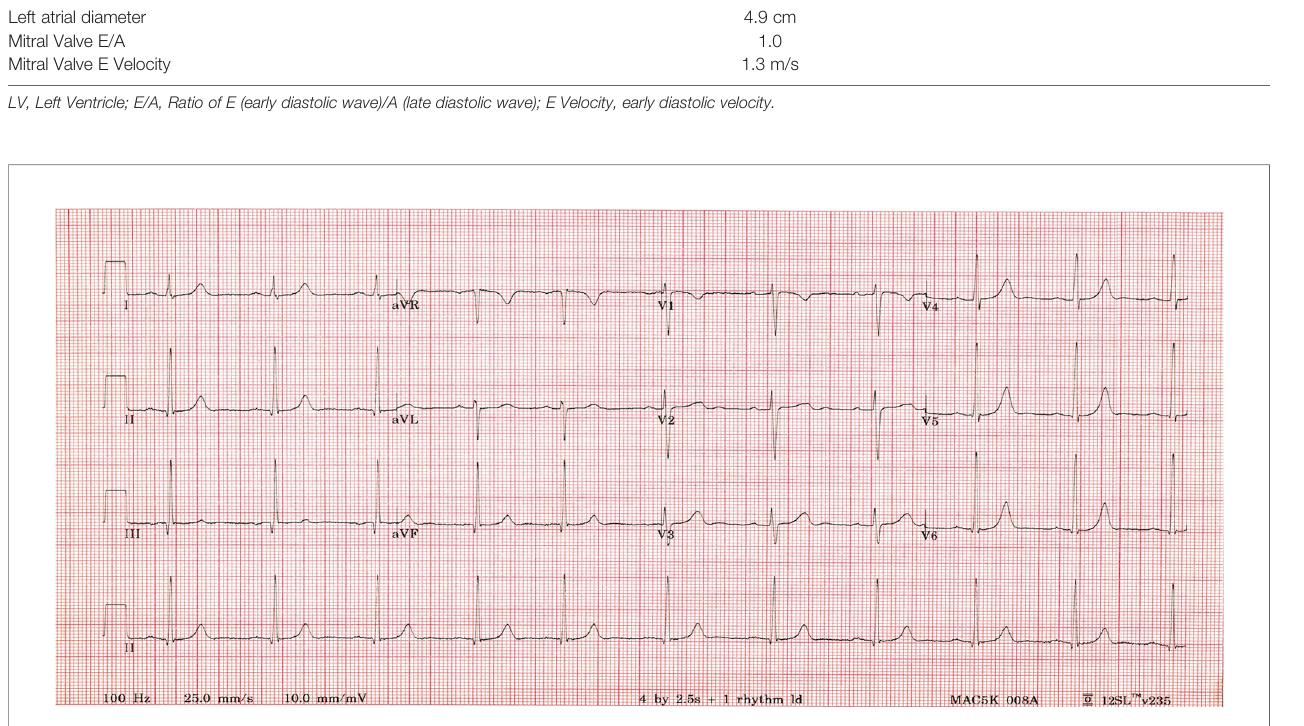
FIGURE 2 | 12 lead ECG demonstrating sinus